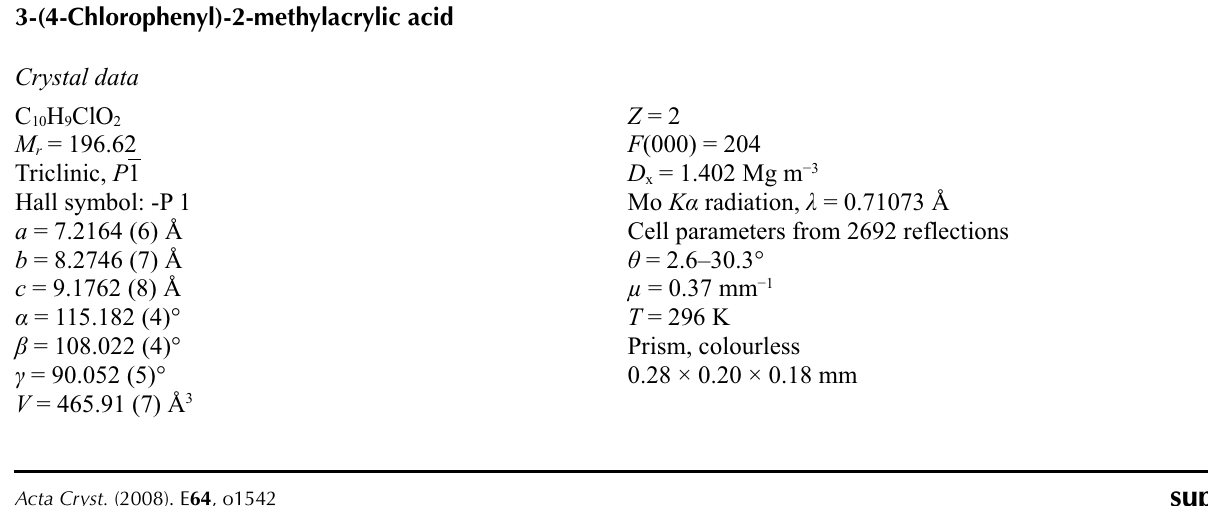
The packing figure ( PLATON : Spek, 2003) which shows the dimeric nature of the compound and the interlinkages of the